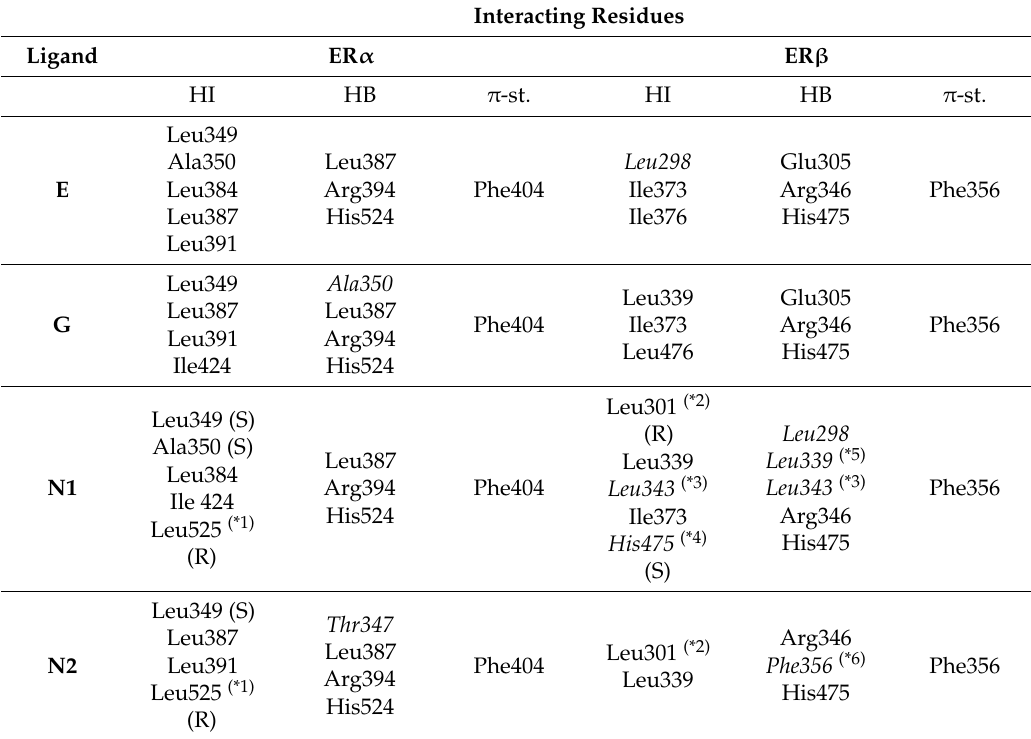
Table 3. Key protein residues of estrogen receptors (ERs) interacting with the ligands. Interactions identified with protein–ligand interaction profiler (PLIP) [51]: HI = hydrophobic interaction; HB = hydrogen bond; π -st. = π -stacking. Interactions with residues in Italics are unique to only one out of the four ligands. (R) or (S) indicate that the interaction in solely formed by either of the two enantiomers of N1 / N2 .